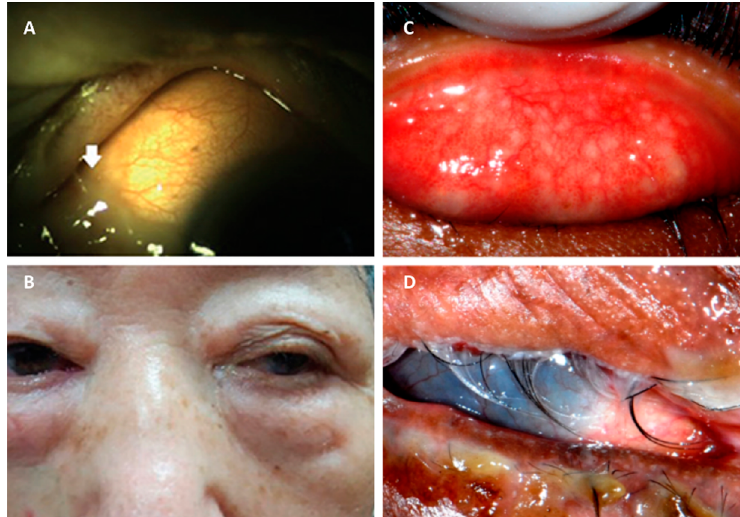
Figure 2. Trachoma and methicillin-resistant Staphylococcus aureus (MRSA) conjunctivitis. ( A ) and ( B ) A patient with MRSA conjunctivitis shows thick mucoid discharge at the conjunctival sac (arrow) of the left eye. ( C ) and ( D ) A patient with trachoma with trachomatous inflammation and follicular and/or trachomatous trichiasis (inversion of eyelashes). This figure is a combination of two edited